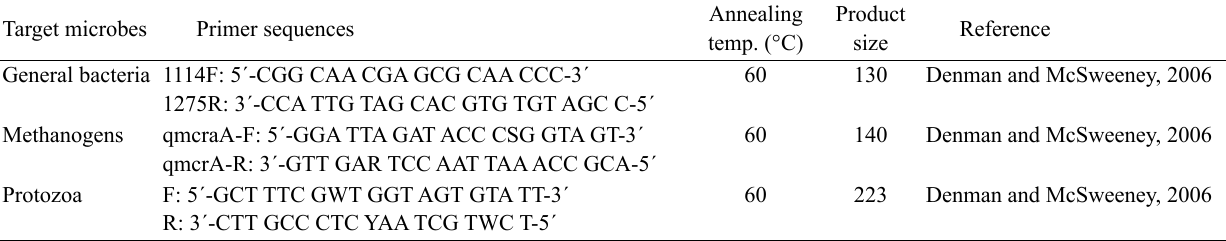
Table 1. Primer used in quantitative polymerase chain